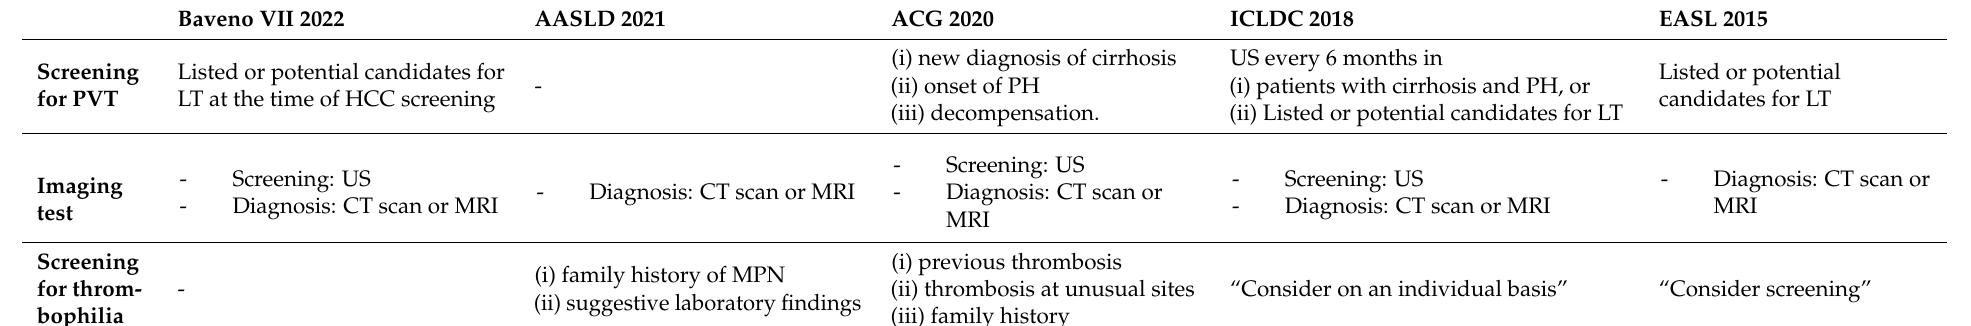
Table 2. Current guidelines recommendations for management of portal vein thrombosis in